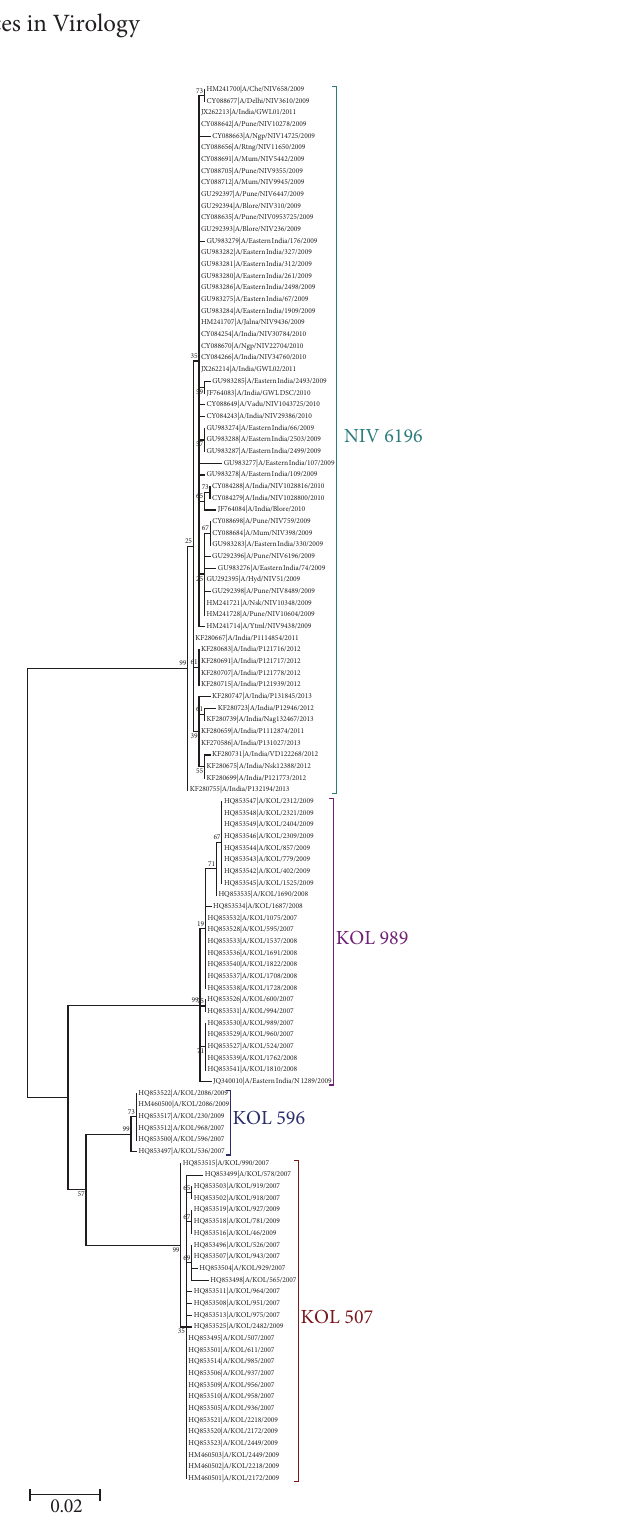
Figure 1: Phylogenetic tree of all sequences (120 sequences from India, 2007–2013) of NS1 gene of influenza A (H1N1) was con- structed using maximum likelihood method in MEGA 6.0 software. Bootstrap values at 500 replications were shown at branches. Each nodeshowingaccessionnumberwithstrainname.Phylogenetictree is depicting 4 major clusters or groups represented by their cluster name given in front of each cluster.